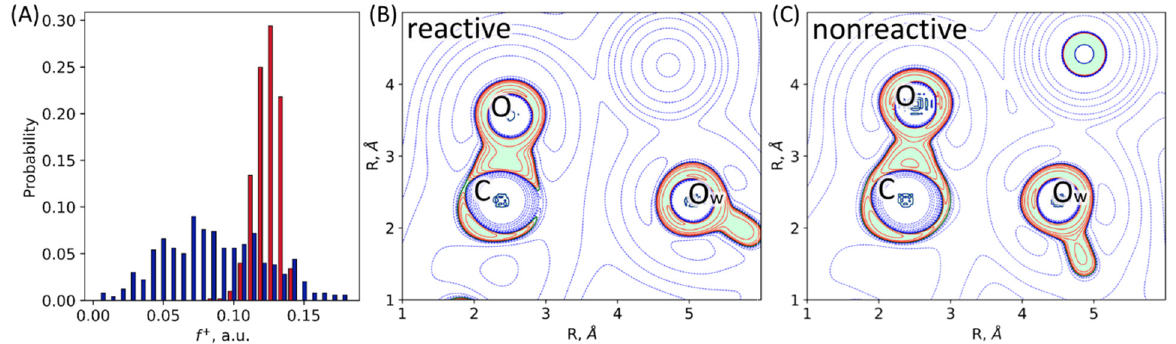
Figure 5. ( A ) Distributions of Fukui electrophilicity indices, f + , on the carbonyl carbon atom of the imipenem in the ES complexes with the L1 (red) and NDM-1 (navy). ( B , C ) Representative Laplacian of the electron density maps in the plane of the carbonyl group of the substrate (C and O atoms) and an oxygen atom, O w , of the catalytic O w H − discriminating, ( B ) reactive, and ( C ) nonreactive ES com- plexes. Contour lines for the Laplacian of electron density maps are ±(2; 4; 8)·10 n a.u., -2 ≤ n ≤ 1, blue dashed contour lines indicate the electron density depletion areas ( ∇ 2 ρ (r) > 0), red solid lines identify the electron density concentration ( ∇ 2 ρ (r) < 0), and green solid line corresponds to ∇ 2 ρ (r) = 0. The area with ∇ 2 ρ (r) < 0 is colored in light green.